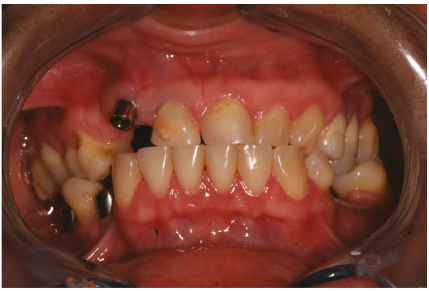
Figure 2: Poorly positioned implant.